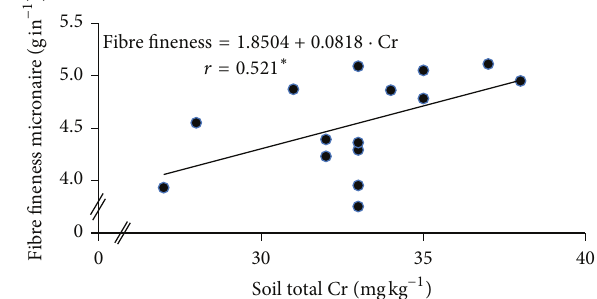
Figure 6: Relationship between Cr content of soil and fibre fineness (micronaire) in the 2003 experiment ( ∗ 𝑝 < 0.05